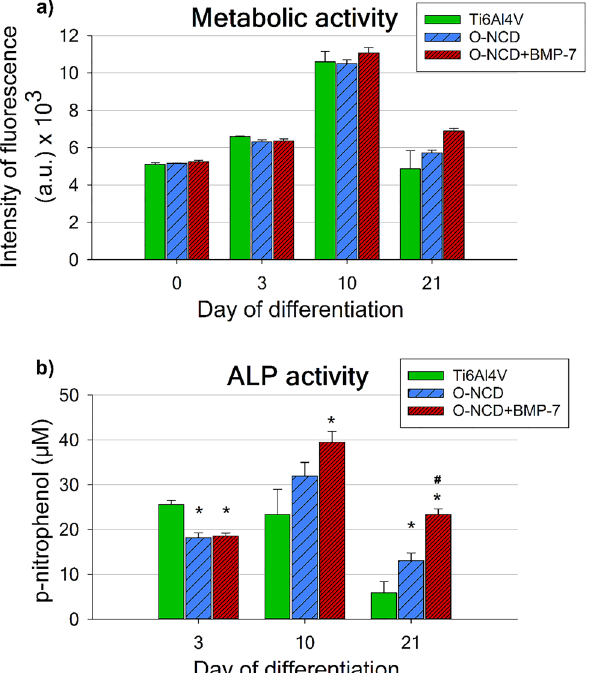
Figure 3. The metabolic activity (a) and the activity of alkaline phosphatase (ALP) (b) of hFOB 1.19 cells cultured on bare Ti6Al4V samples (Ti6Al4V), on Ti6Al4V samples coated with the O-terminated nanocrystalline diamond coating (O-NCD), or on Ti6Al4V samples coated with the O-terminated nanocrystalline diamond coating functionalized with BMP-7 (O-NCD + BMP-7) under differentiation conditions (a restrictive temperature of 39.5 °C) for 3 weeks. Mean ± S.E.M. * indicates a significant difference from the reference Ti6Al4V, while # shows a significant difference from the O-NCD coating; p <